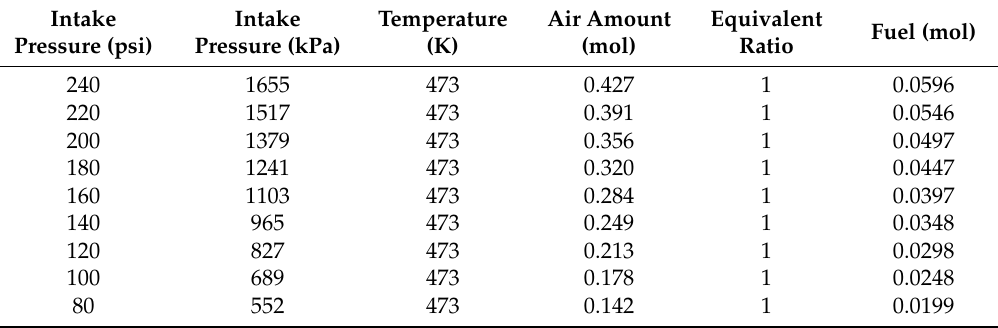
Table 3. Methanol air amount constant test data.